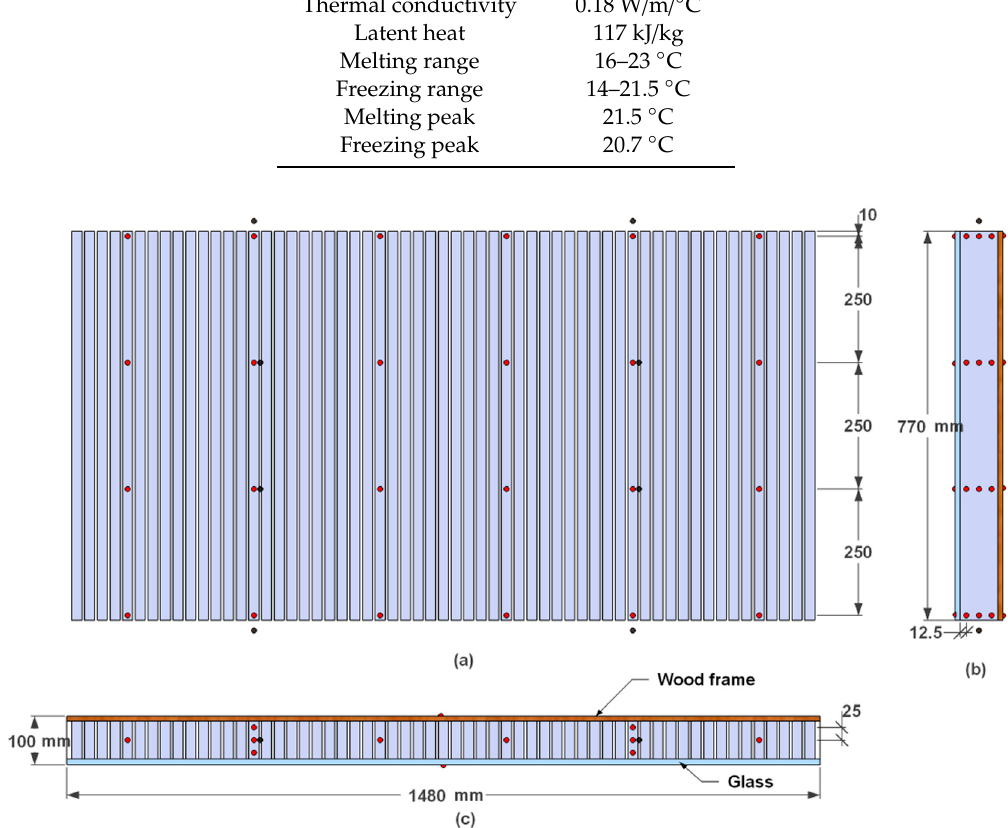
Figure 2. Locations of the sensors for the monitoring of the PCM air temperatures in the heat exchanger for experimental and simulation cases [31]: ( a ) front view; ( b ) side view; ( c ) top view.